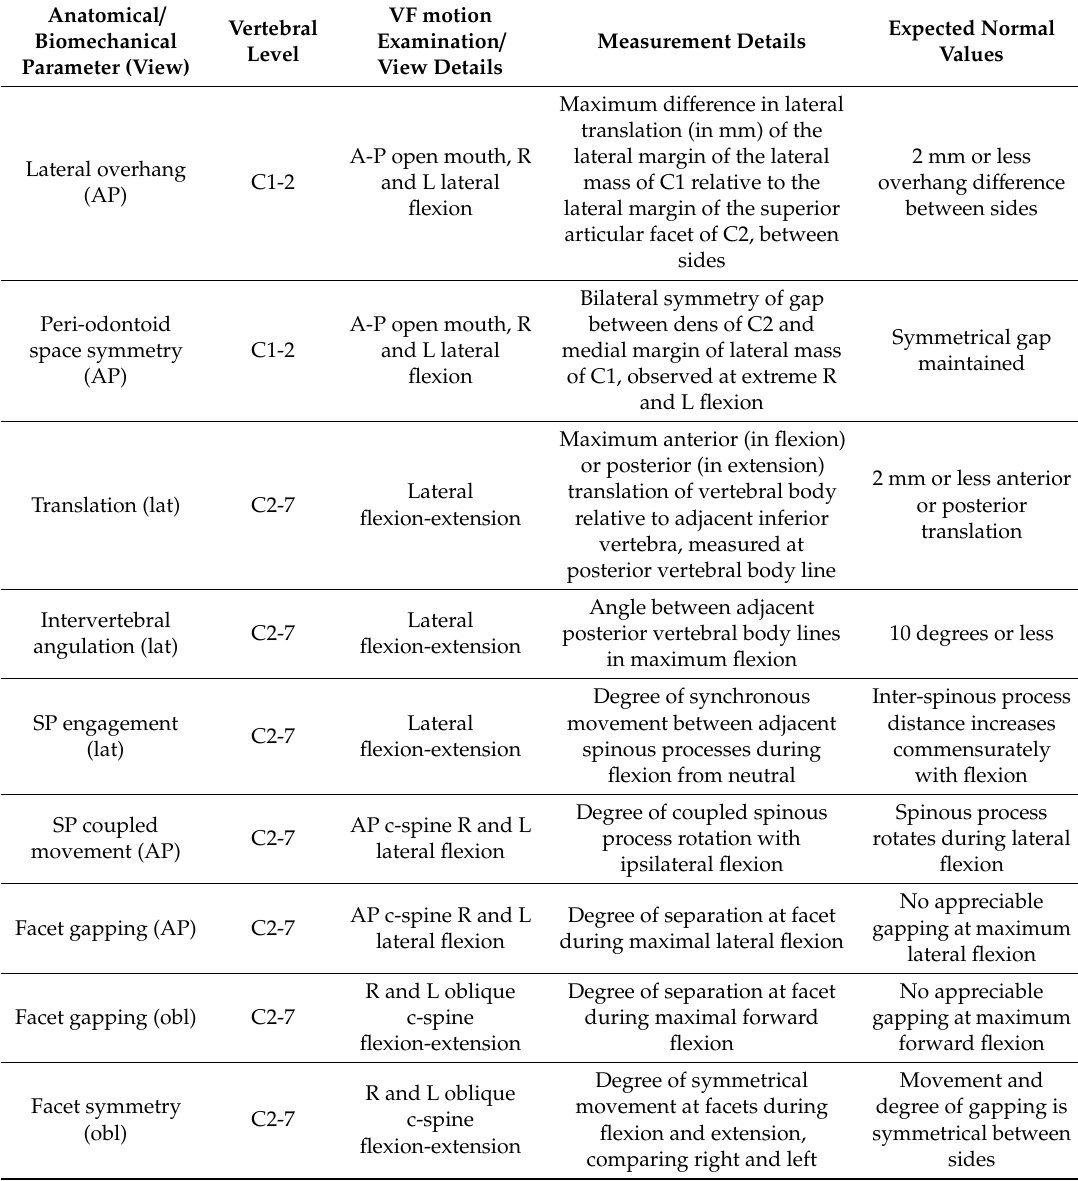
Table 1. Measured parameters of videofluoroscopy (VF) views /